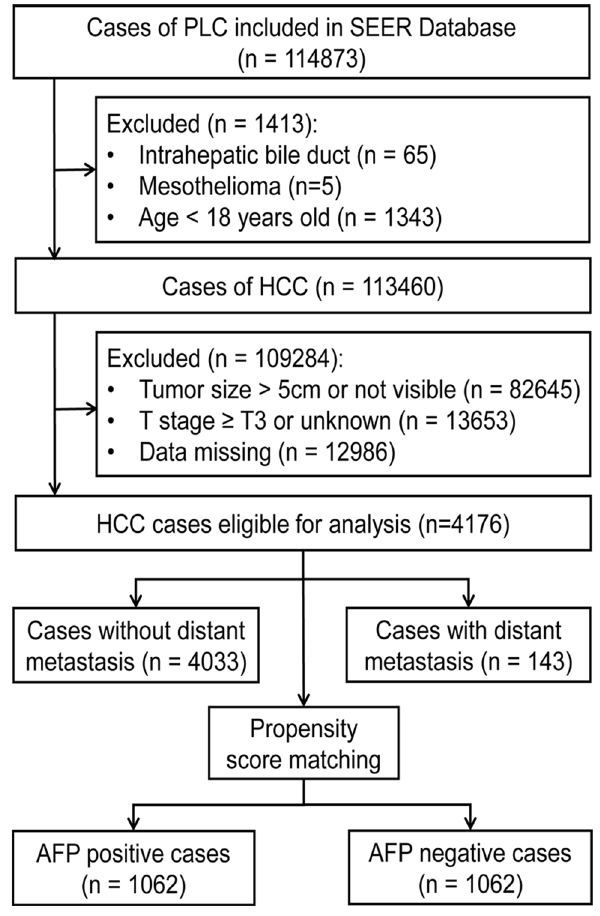
Figure 3. Flow chart of patient enrollment. PLC primary liver cancer, SEER the Surveillance, Epidemiology, and End Results (SEER) program of National Cancer Institute, HCC hepatocellular